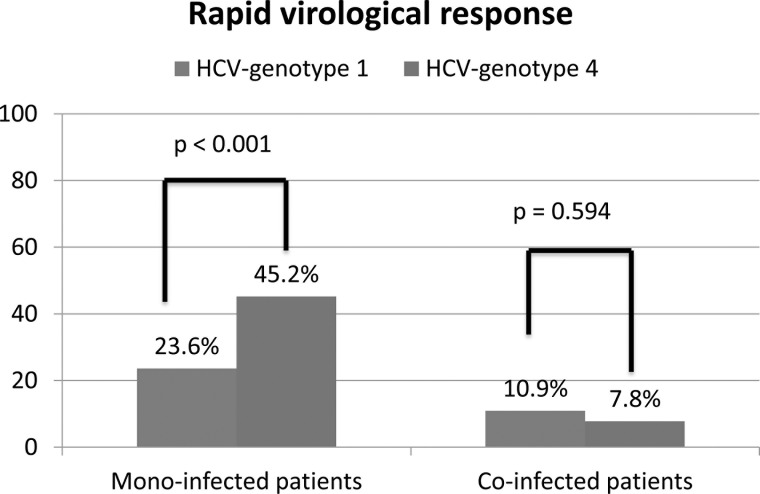
Rapid virological response in patients segregated with respect to
mono-infection or co-infection